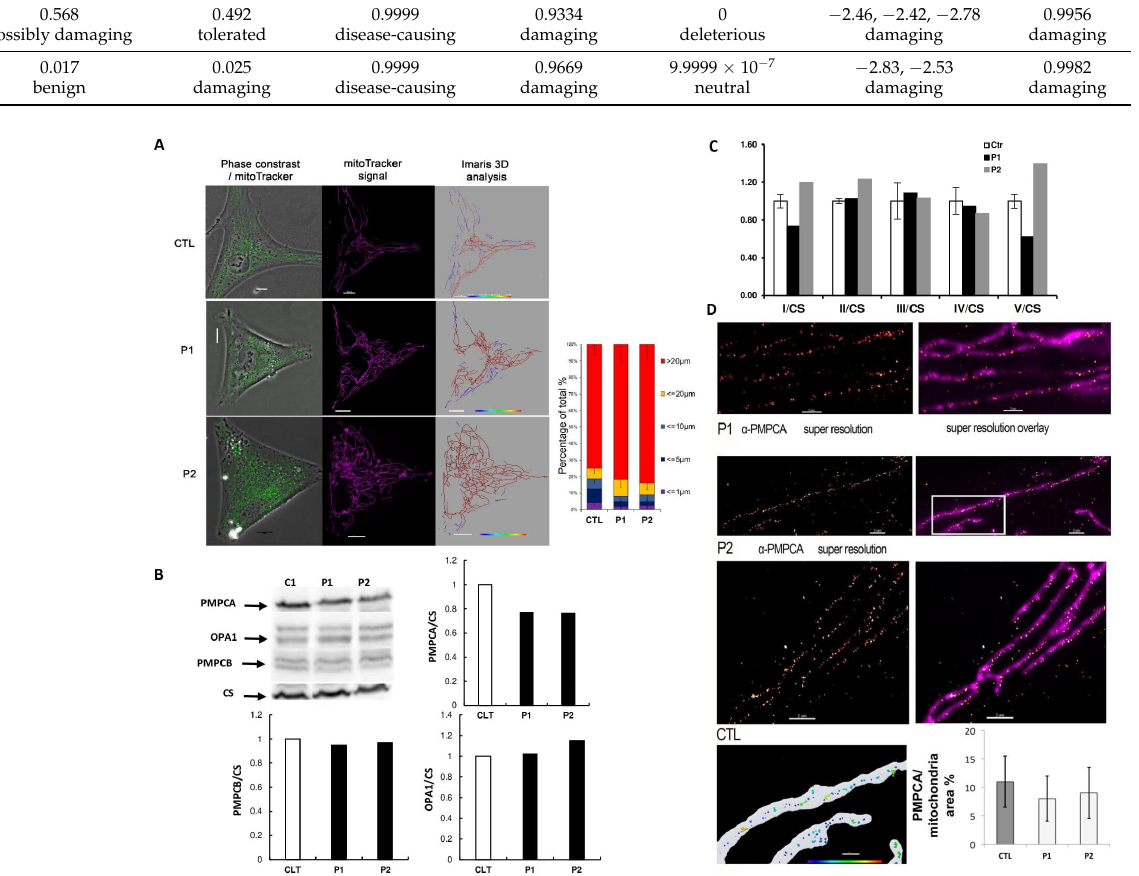
Figure 2. Mitochondrial dynamic and PMPCA distribution studies of fibroblasts from control and PMPCA mutated patients. ( A ): Representative fluorescent images of mitochondrial network structure overlaid on phase-contrast (on the left) showed a mitochondrial network hyperconnection in PMPCA fibroblasts. Mitochondrial volume (in purple on black background in the middle) was assessed using the Mitotracker Green fluorescent signal by Imaris software and color-coded on the right. The inset illustrates the classification code. To present the changes in mitochondrial morphology in patients’ cells, types of mitochondria were classified into 5 groups according to mitochondrial length: blobs < 1 µ m; fragmented < 5 µ m; tubular < 10 µ m; filamentous < 20 µ m; mitochondrial network > 20 um. Bar graphs show the distribution of the mitochondrial population of Control, P1 and P2. Mean ± SEM. Scale bar: 10 µ m. ( B ): Western blots (left) against PMPCA, PMPCB, OPA1 and citrate synthase (CS) on control (C1) and two patients’ (P1 and P2) fibroblasts reveal decreased levels of PMPCA and equal levels of PMPCB and OPA1 in the pathological conditions, as shown on the histogram (right). ( C ): Enzymatic activities of the respiratory complexes (CI to CV) from the control and the PMPCA mutated fibroblast strains related to the citrate synthase (CS) enzymatic activity, did not reveal a significant difference between control and mutated fibroblasts. Biochemical data were generated using the two-tailed paired t -test. Results are Mean ± S.E.M. from four independent experiments. ( D ): Single-molecule localization microscopy dSTORM was used to analyze PMPCA distribution, correlated to total internal reflection fluorescence TIRF microscopy for mitochondrial staining. Using Imaris 8.0 ® software, the dSTORM PMPCA immunofluorescence signal was used to quantify their mitochondrial surface protein